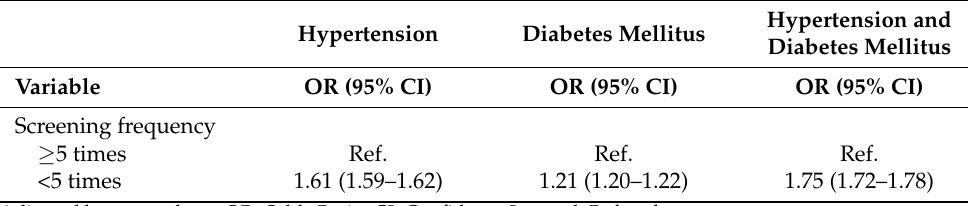
Table 2. Logistic regression of hypertension and diabetes mellitus according to screening fre- quency